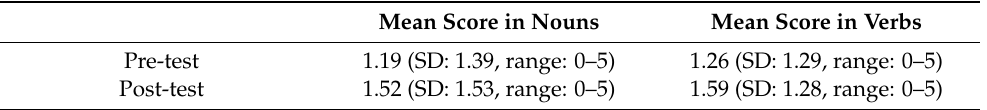
Table 10. Pupils’ performance on nouns and verbs for the pre- and post-test of the contextual cues intervention.